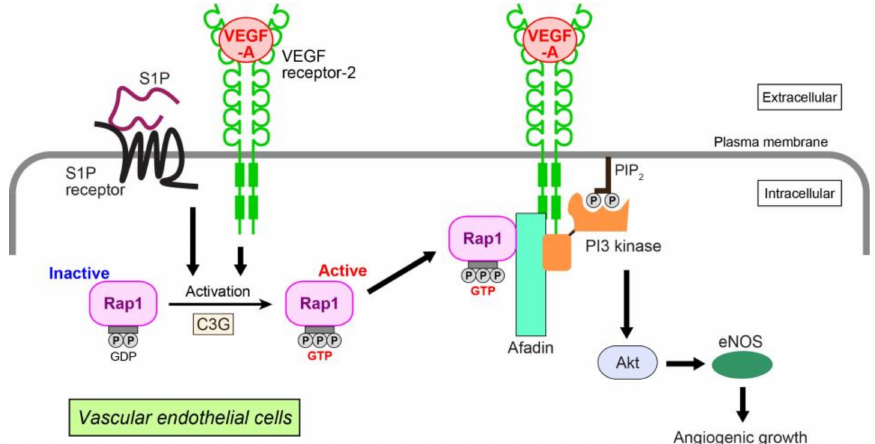
Figure 2. Angiogenic growth induced by VEGF-A or S1P in vascular endothelial cells. VEGF-A and S1P activate Rap1 through a Rap1-GEF C3G by binding to their cognate receptors. Activated Rap1 interacts with afadin, an adaptor protein, and recruits afadin and PI3 kinase to the plasma membrane of the leading edge, where VEGF receptor-2 associates with these molecules. Akt and eNOS are then activated, enhancing the angiogenic growth of endothelial cells. PIP 2 : phosphatidylinositol (4,5)-bisphosphate. 5. Mode of Association between VEGF-A and Rap1 at the Molecular